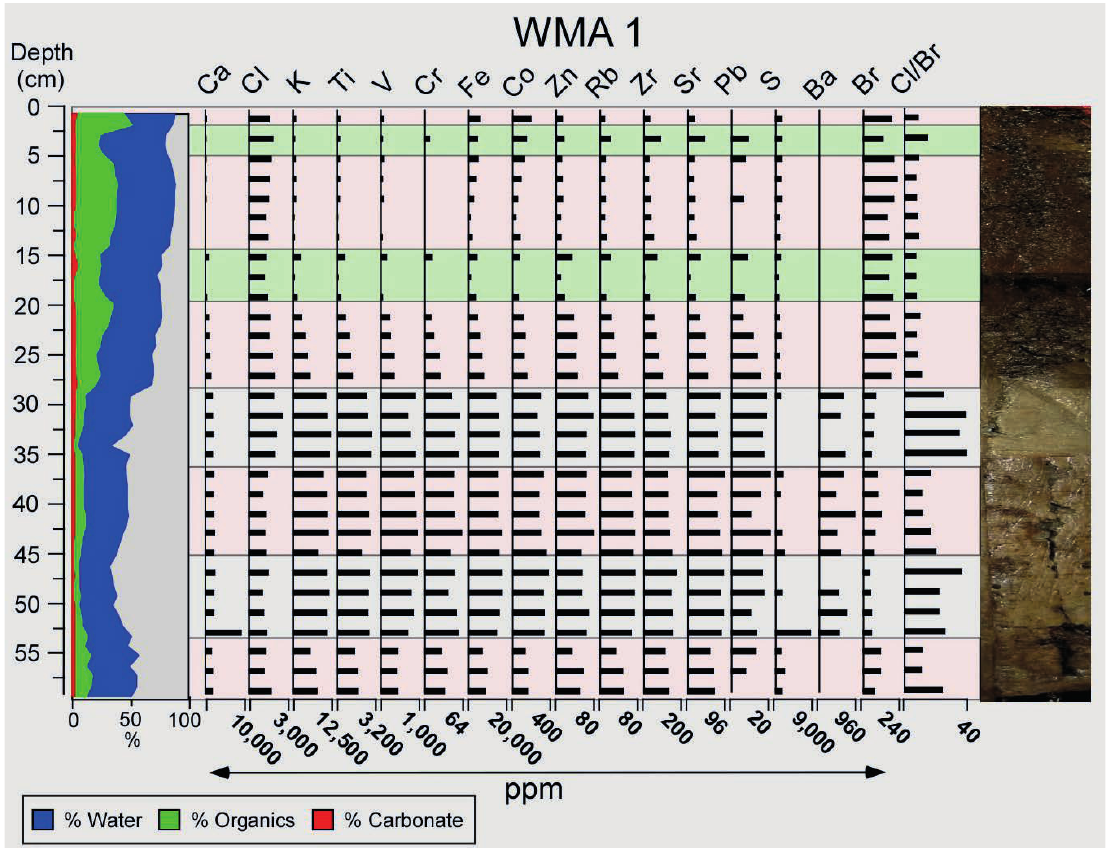
Fig. 3 Core WMA 1. LOI graph is on the left, showing percentages of water, organics and carbonates. Elemental concentrations in ppm are shown in the centre and a core photograph is displayed on the right. The red shading highlights intervals of elevated organic content, the green shading outlines the Isaac layer (3–5 cm) and a possible earlier flood